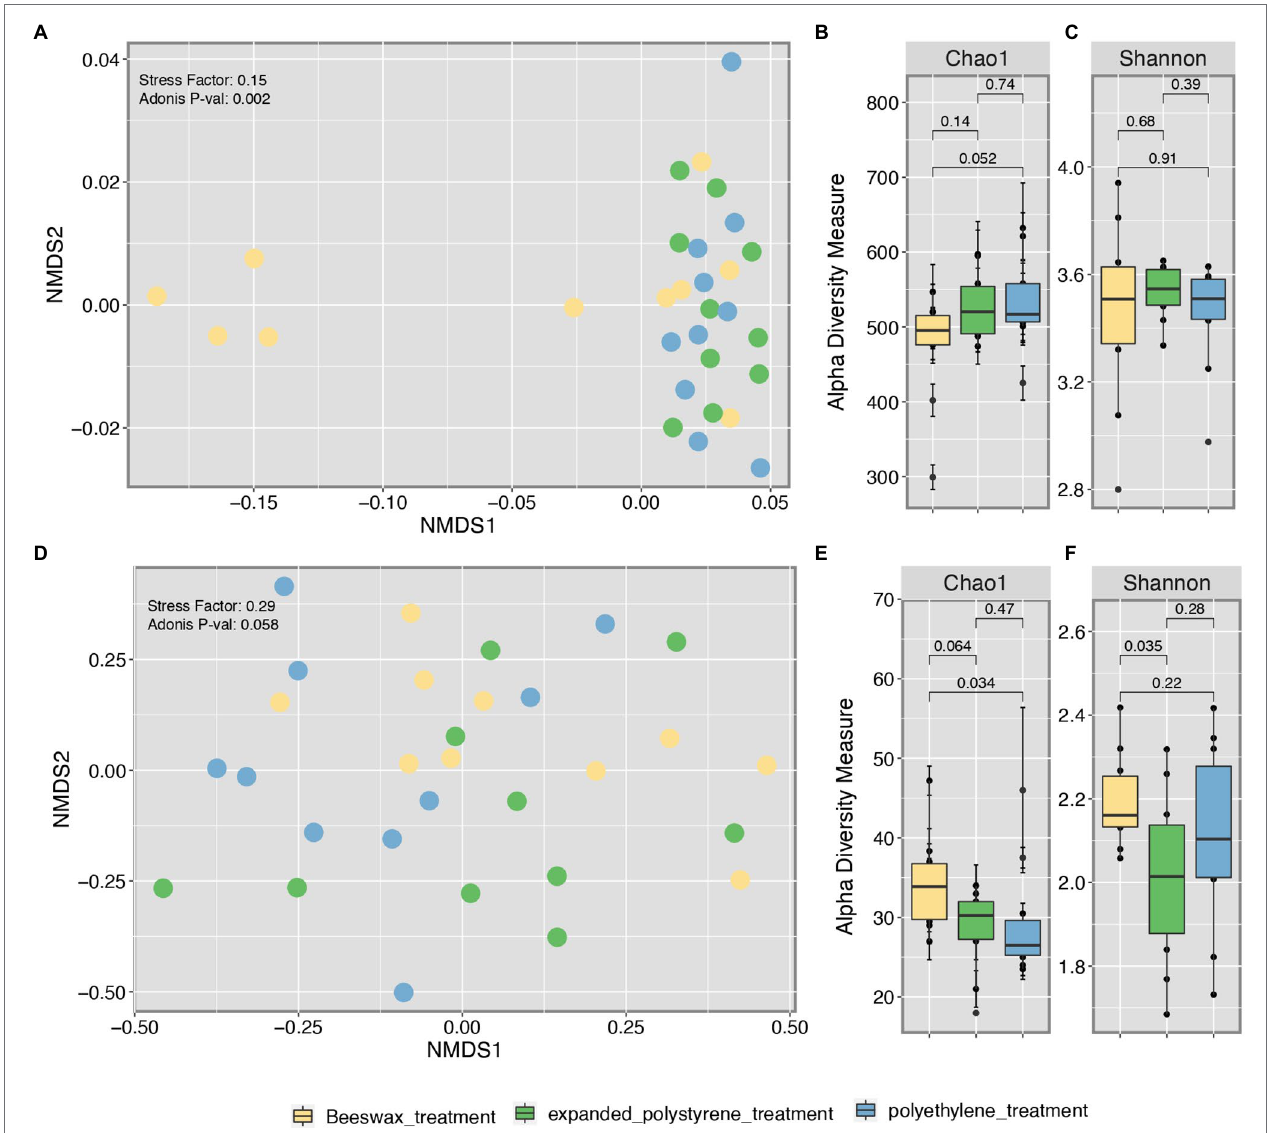
FIGURE 1 | Beta diversity (NMDS) of bacterial (A) and fungal (D) communities. Species Richness based on Shannon (B) and Chao diversity indexes for bacterial (B,C) and fungal (E,F) communities with statistical significance value calculated through Wilcoxon pairwise